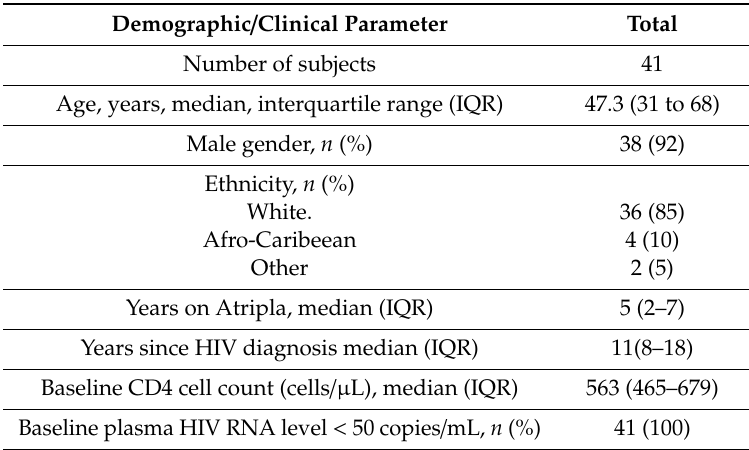
Table 2. Demographic characteristics at